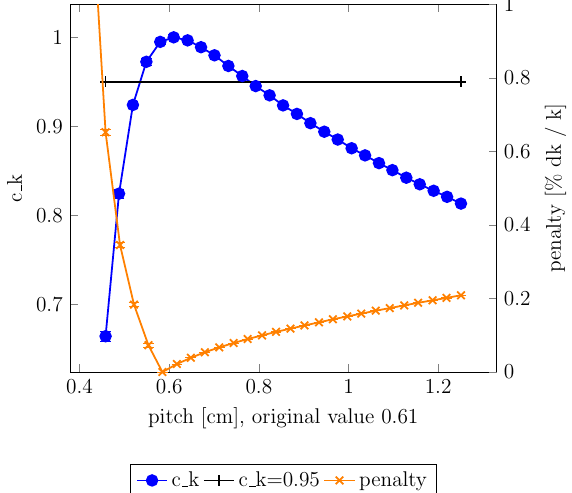
Figure 3. Evaluation of similarity between systems with different pitches.